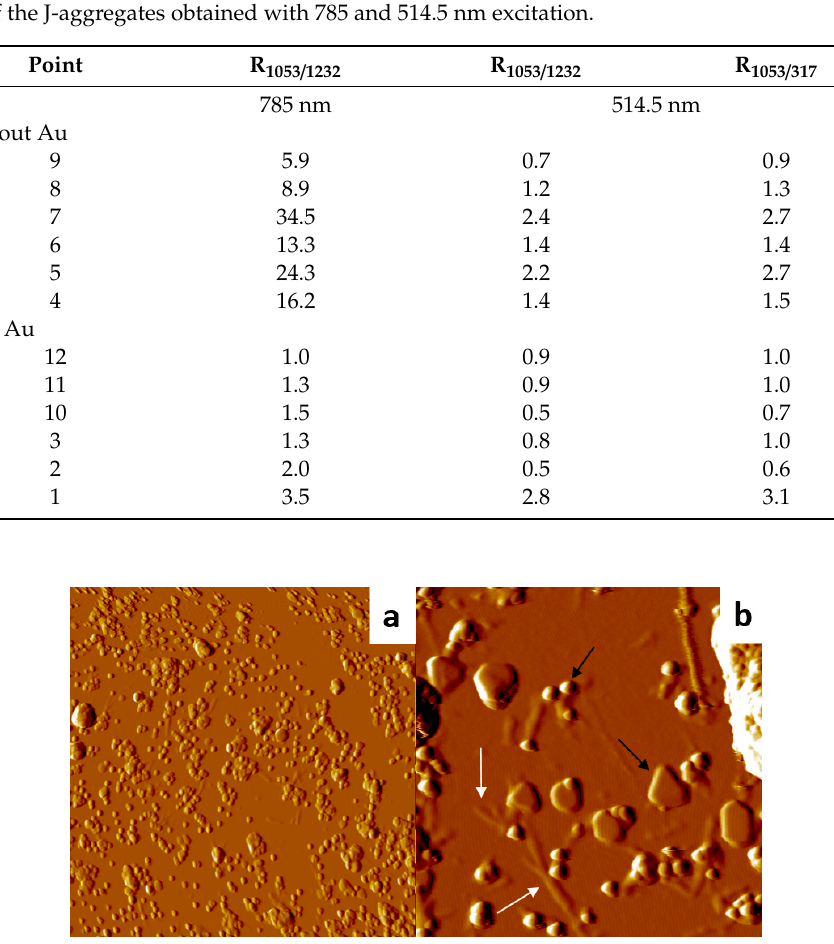
Figure 7. AFM topography images (x gradient) of the deposits formed on a glass substrate immersed in a Au 10 and TPPS solution at pH 2.0, showing Au nanostructures (dark arrows) with J-aggregates (white arrows). Experimental conditions: ( a ) 9 × 9 µ m, Z range = 478 nm; ( b ) 2 × 2 µ m, Z range = 145 nm.